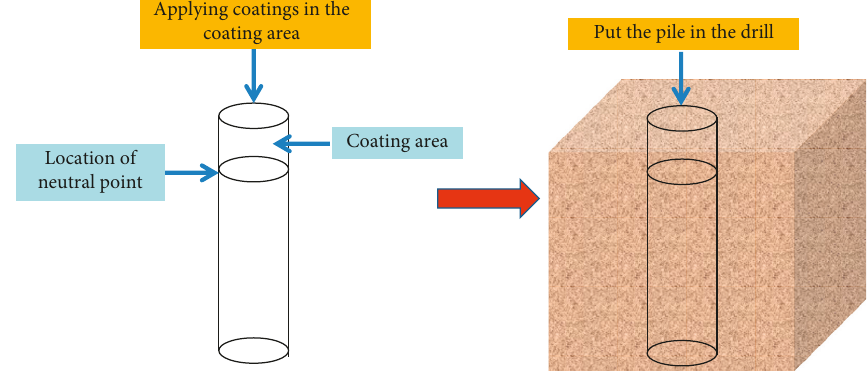
Figure 10: Schematic of the construction process.